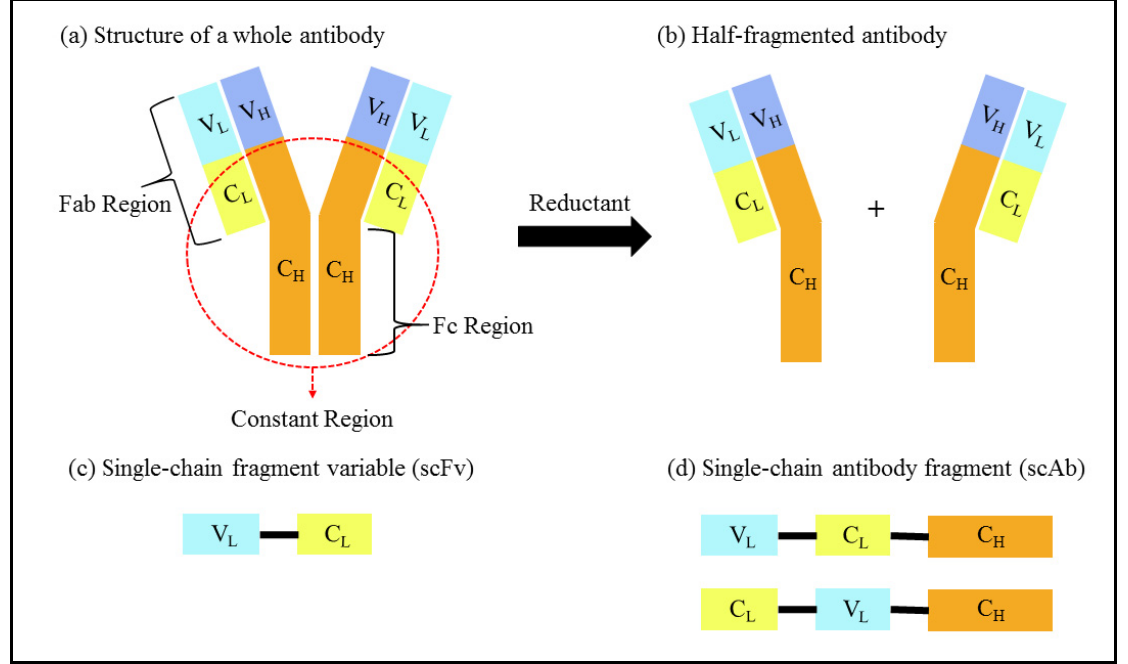
Figure 2. Schematic diagram of ( a ) the structure of a complete antibody and different types of antibody fragment after cleavage, ( b ) a half-fragmented antibody, ( c ) a single-chain fragment variable (scFv) and ( d ) a single-chain antibody fragment (scAb). V L , variable light; V H , variable heavy; C L , constant region in light chain; C H , constant region in heavy chain; Fab, antigen-binding fragment; Fc, fragment